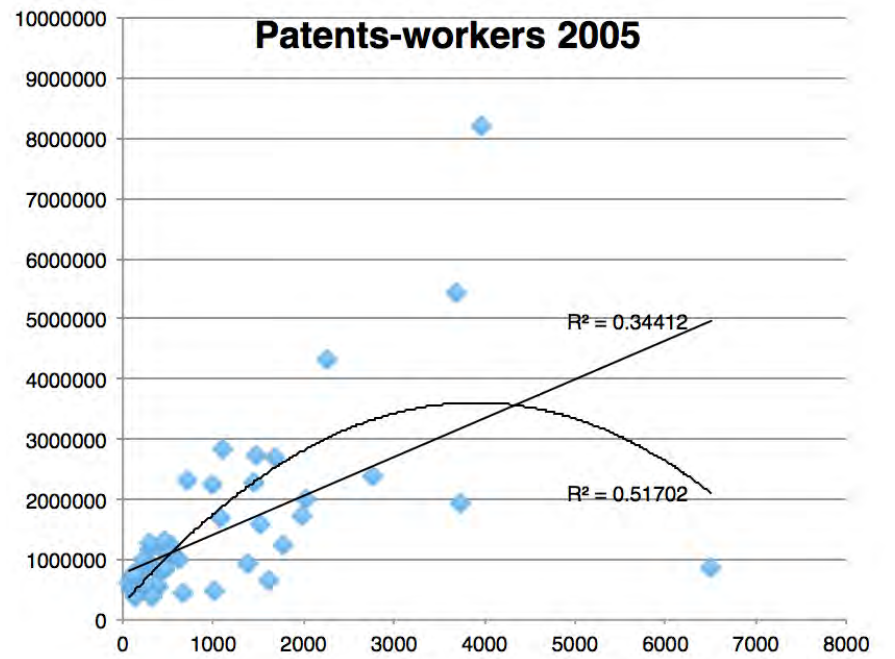
Figure 5. Linear and power regression patents - workers 2005